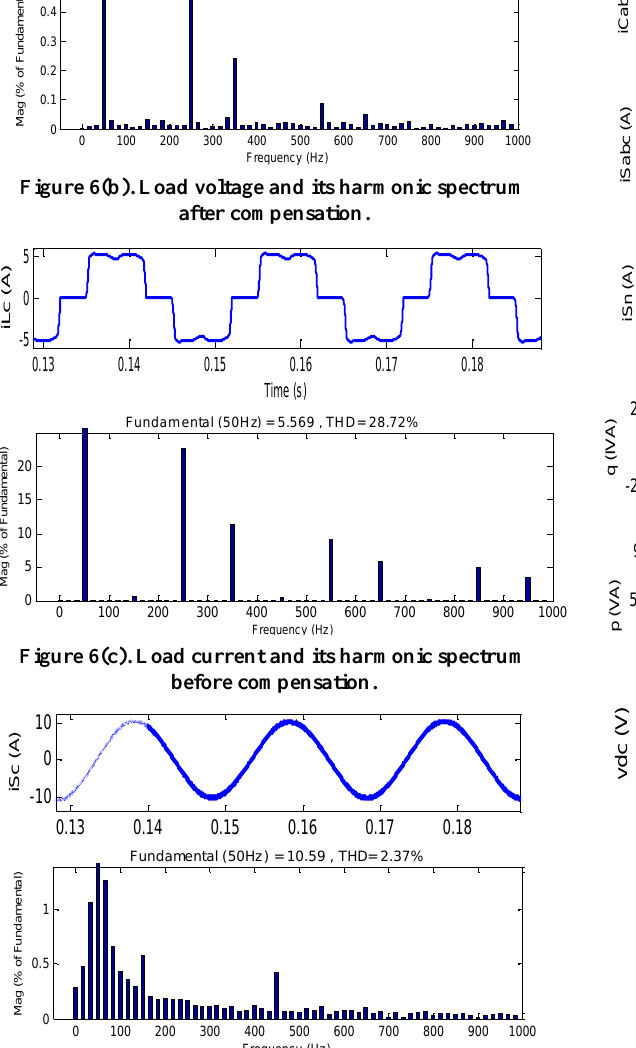
Figure 6(c). Load current and its harmonic spectrum before compensation.